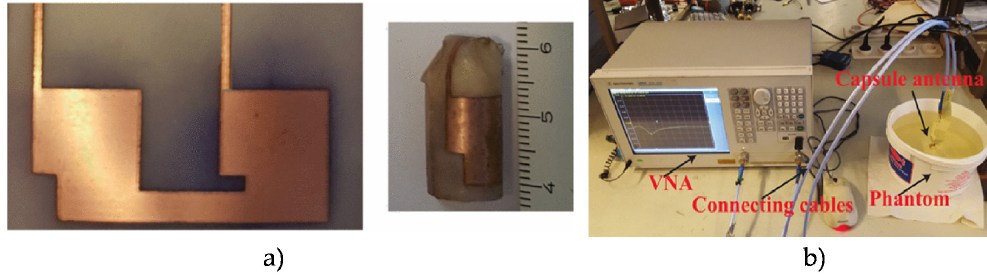
Figure 14. Antenna for ingestible application. ( a ) Fabricated capsule antenna and ( b ) measurement setup using Agilent e5063A vector network analyzer [226].